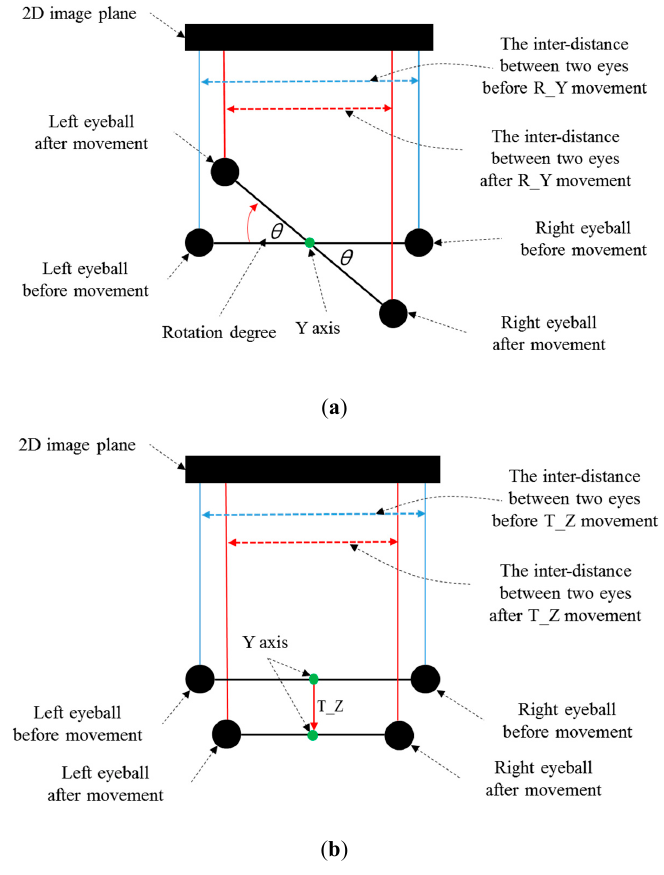
Figure 7. Difference of the inter-distance between two eyes before and after ( a ) R_Y movement ( b ) T_Z movement (top view).